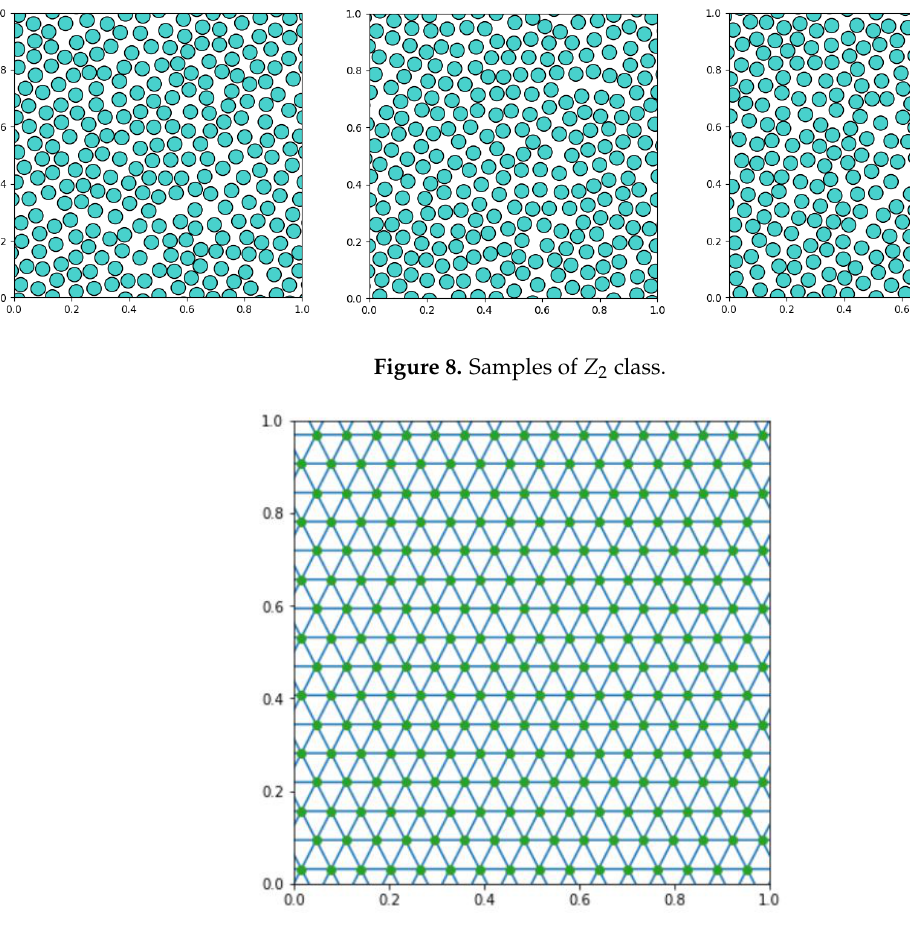
Figure 9. Regular Delaunay triangulation generated on hexagonal